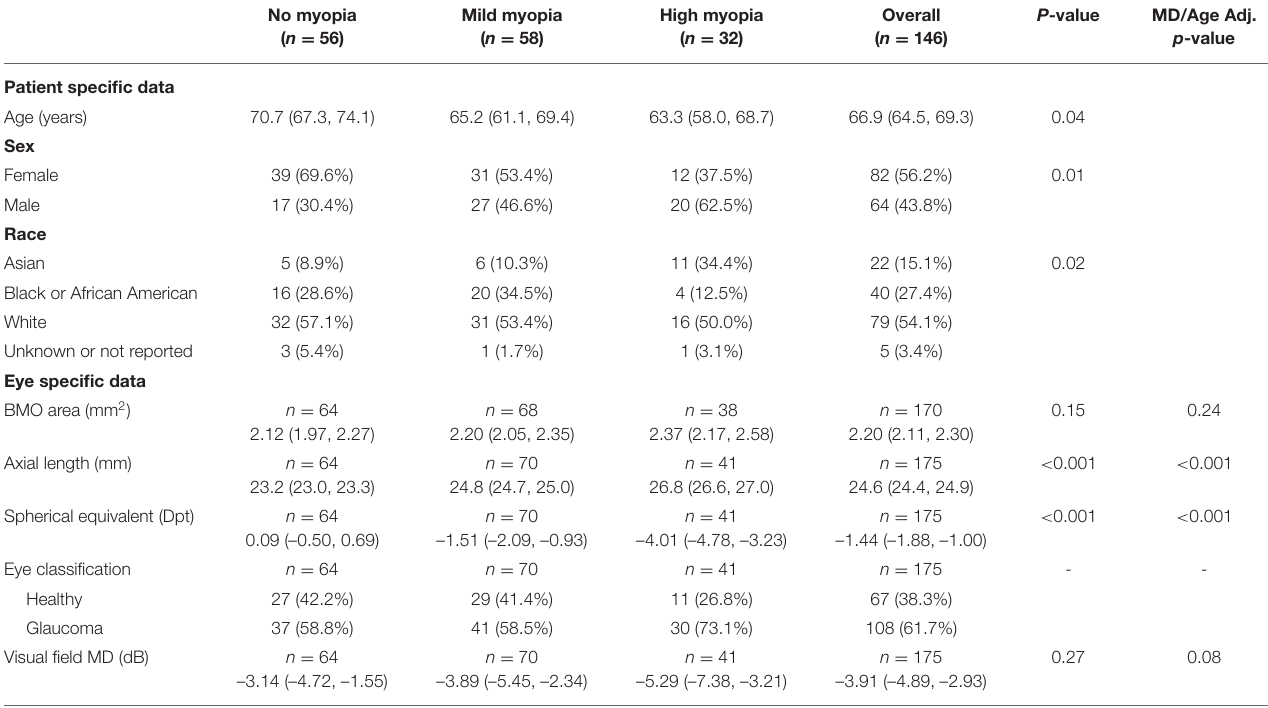
TABLE 1 | Patient characteristics by myopia status.